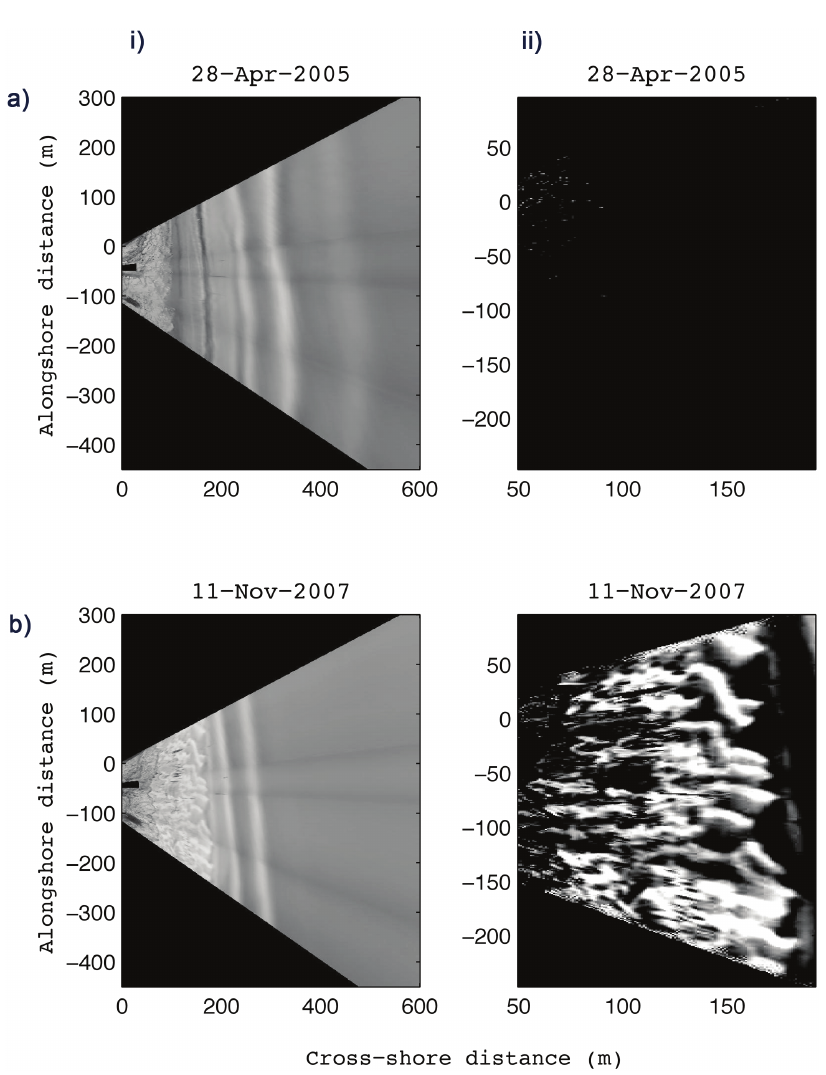
Figure 4 - Sample images to demonstrate the process of dune presence or absence. Left column (i) shows timex merged images, without ( a ) and with ( b ) ephemeral dunes at the backshore; right column (ii), it is a closer view of the backshore zone in gray scale of those same images shown in